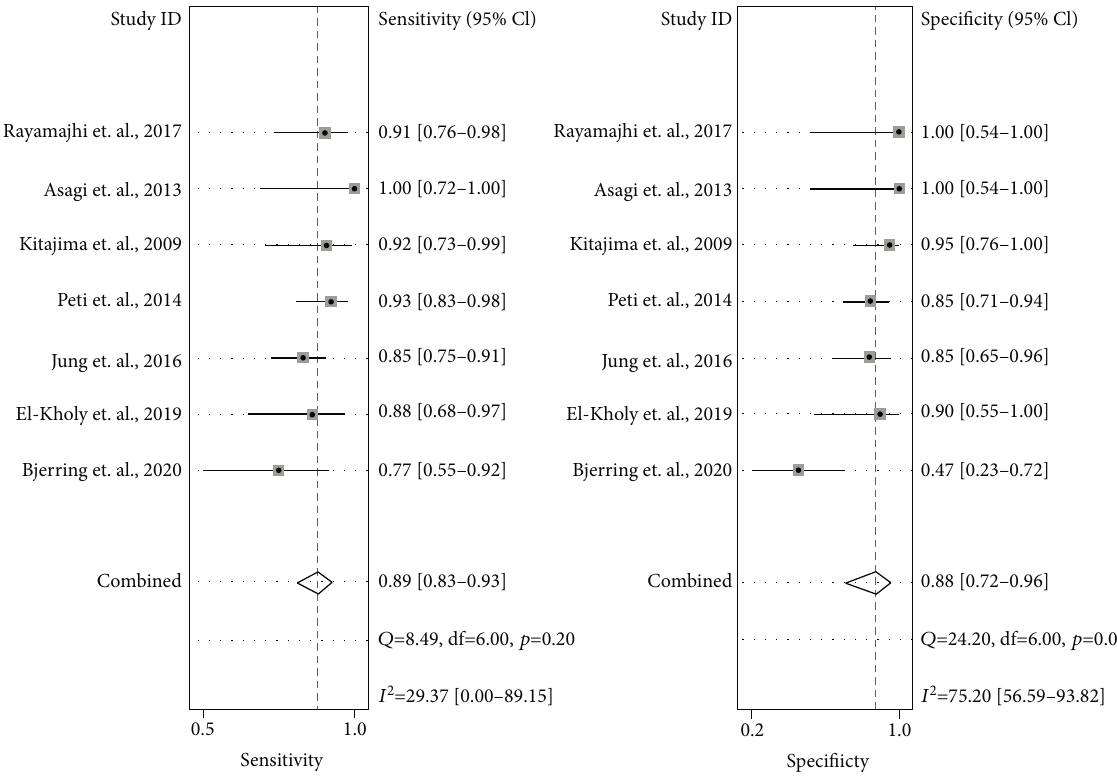
Figure 3: The sensitivity and speci fi city of 18F-FDG PET/CT for recurrent pancreatic cancer is shown in a forest plot.